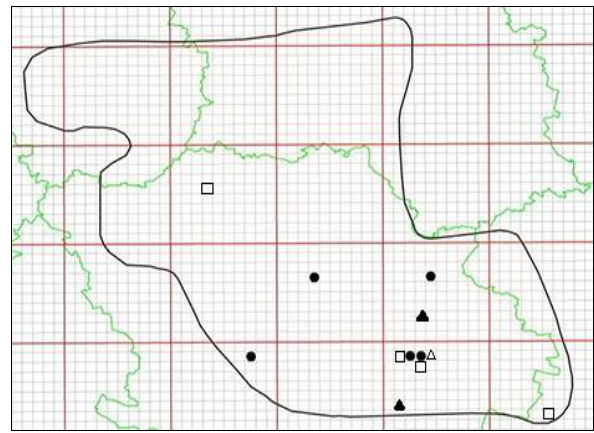
Fig. 7. The distribution of selected ephemerophytes in the Romensko-Poltavsky Geobotanical District: A. - Petasites spurius (Retz.) Rchb.; B. - Xanthium ripicola Holub × Xanthium albinum (Widder.) H. Scholz.; C. - Echinochloa tzvelevii Mosyakin ex Mavrodiev & H. Scholz; D. - Panicum capillare L.